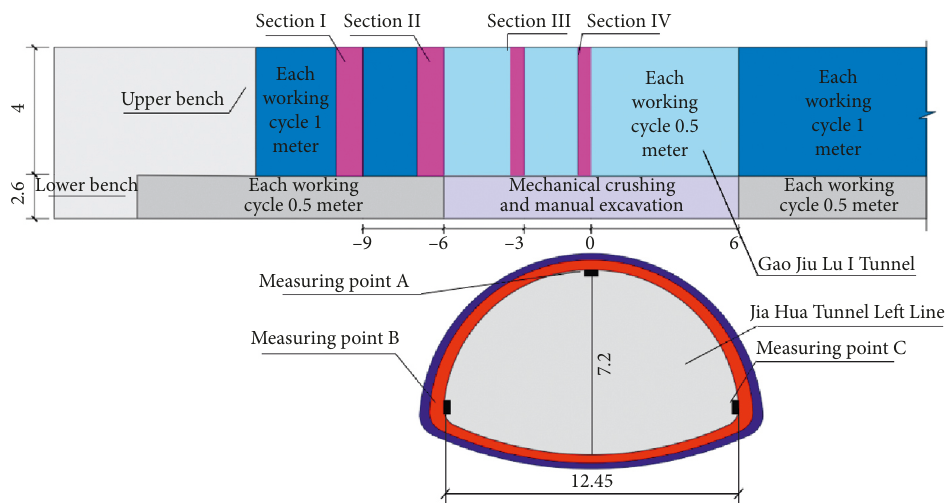
Figure 3: Excavation method of Gao Jiu Lu I Tunnel and layout of measuring points on Jia Hua Tunnel Left Line (unit: